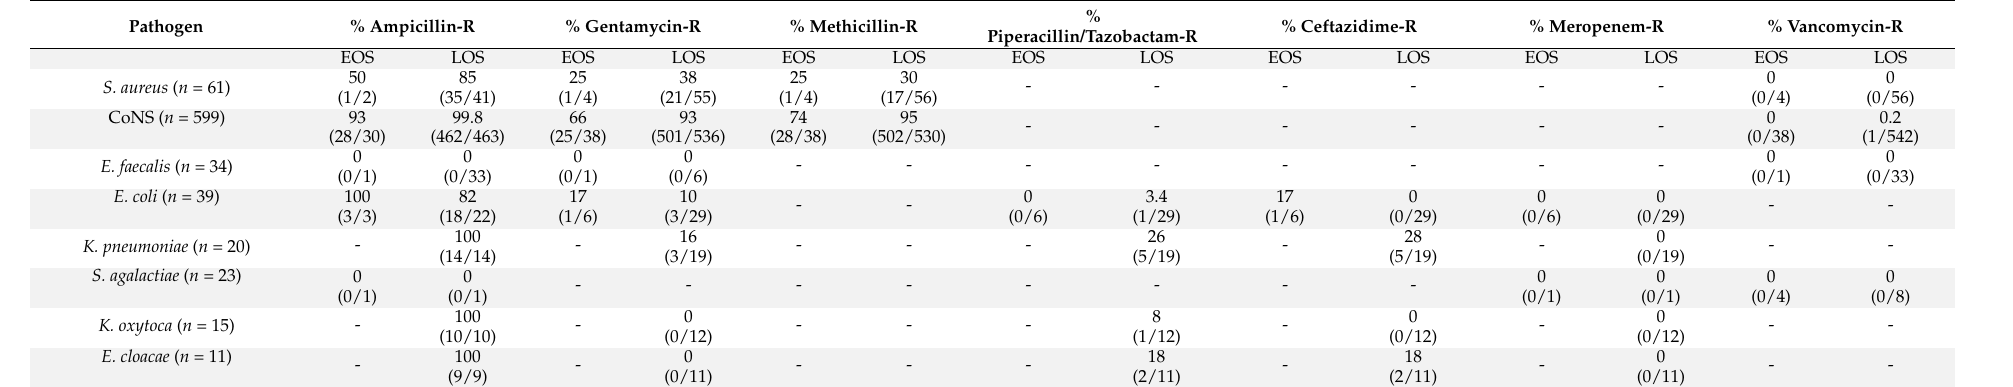
Table 2. Antibiotic resistance profiles for pathogens with > 10 isolates. EOS: early-onset sepsis; LOS: late-onset sepsis. R =